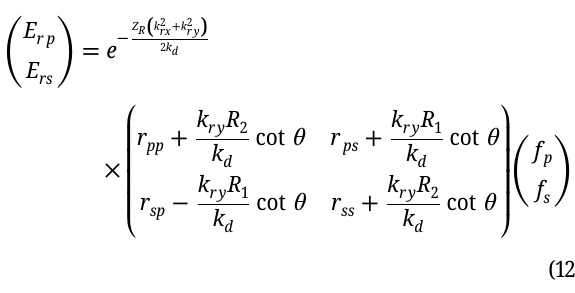
= 100 nm and d = 150 m c